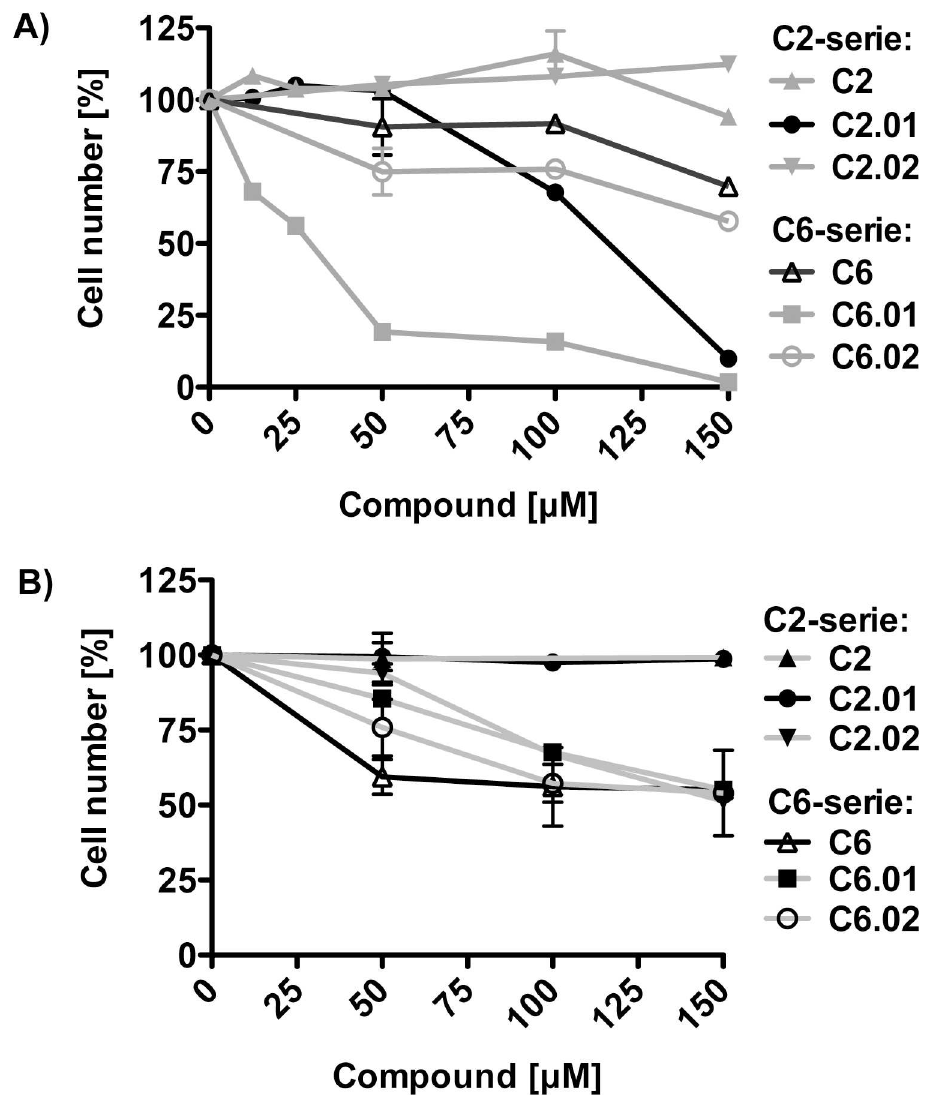
Fig 6. Cell toxicity of compound C2, C6, and their 2D analogs tested in a cancer cell line and normal fibroblasts. A) SCC 22B cells were treated with increasing concentrations of the indicatedcompoundand 48 hours later cell numbers were determined (n = 3). B) MRC5 cells (fibroblast)were treated with increasing concentrations of the indicatedcompoundsand 48 hours later cell numbers were determined using the CyQuant kit (n =